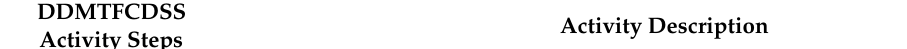
Table 4. Previous steps to the iterative design for the framework for the development of Data-driven Mamdani-type CDSS.